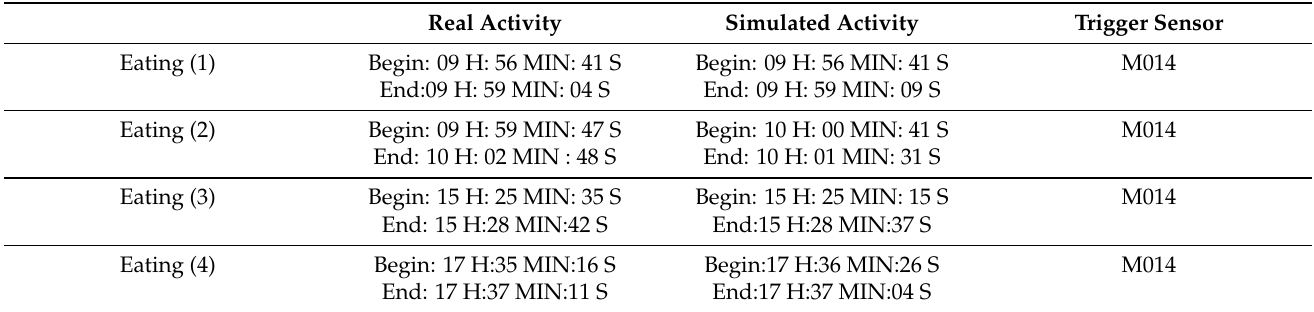
Table 4. Timestamp comparison between real and simulated activities on 4 November 2010.